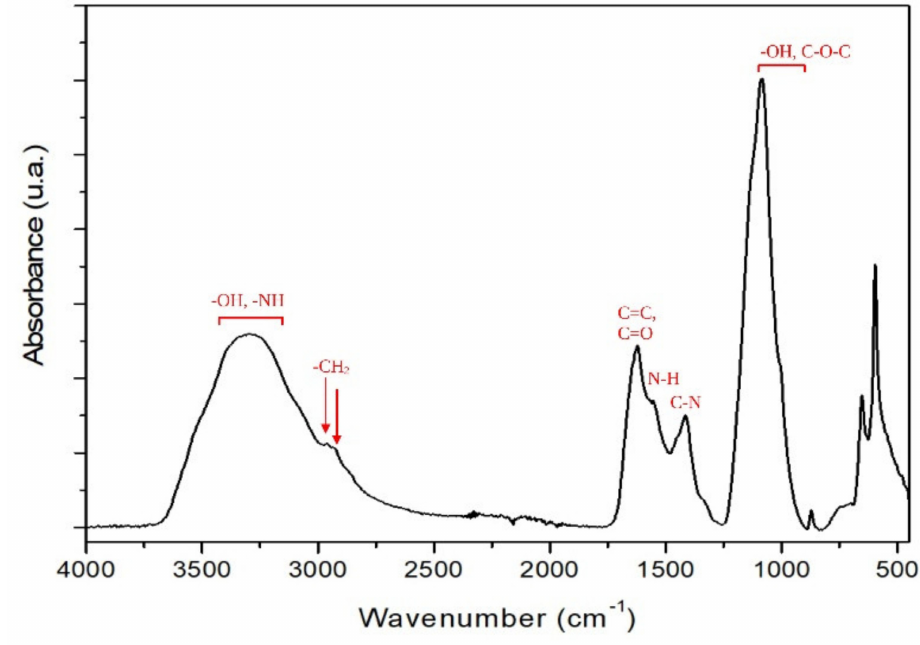
Figure 6. FTIR-ATR spectrum of the melanin pigment produced by B. haynesii